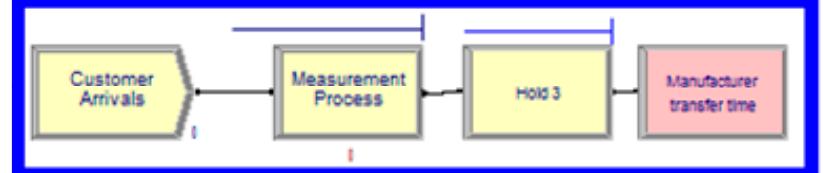
Figure 13. Customer arrivals to the orthopedist. Logistics 2018 , 1 , x